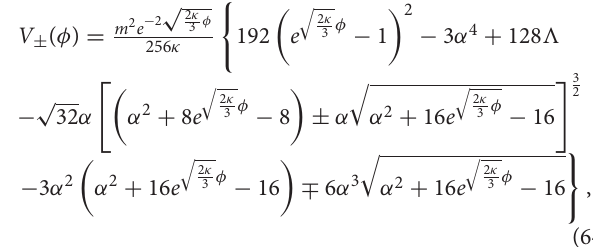
FIGURE 2 | Inflationary potentials V ( φ ) produced by the conformal transformation of the action (43) for various values of the critical exponents θ 1 fixed-point potential V * 8 π g * λ * M 4 Pl associated with the fixed-point action S * grav , Equation (46), is also shown for comparison. It corresponds to an exactly scale = invariant scalar power spectrum, n s 1. When the RG flow departs from the NGFP, additional operators are generated by the flow. These operators break the perfect = scale invariance realized at the NGFP and destabilize the fixed-point potential, V * V ′ ( φ i ) / 3 H ( t i ). The subsequent dynamics depends crucially on the critical exponents θ i . In particular, the case θ 1 a RG-induced kinetic energy, ˙ φ i ∼ − reproduces the well-known Starobinsky